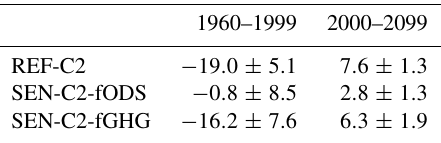
cant ( p < 0 . 05), the line is solid; if the test shows no signif- Table 1. Trend in the centre longitude ( ◦ decade − 1 ) for each of the model ensembles. Uncertainty is indicated by the 95% confidence